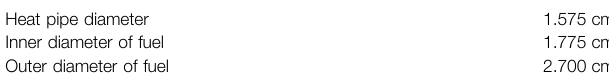
TABLE 2 | Geometric Parameters of the annular fuel